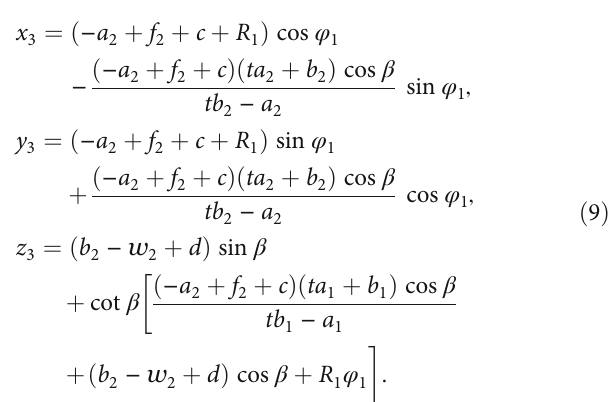
F IGURE 5: Schematic diagram of the gear 2 concave tooth surface formation. to z axis. The subscript of the expression symbol in Figure 5 2 is changed from 1 to 2.